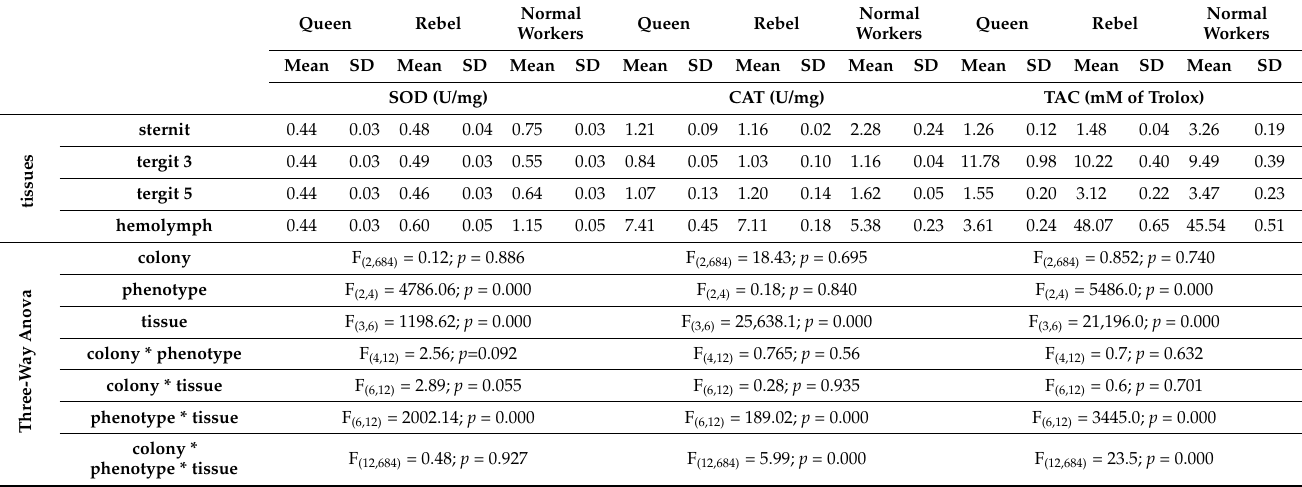
Tergit 3—the fat body from the third tergite; tergite 5—the fat body from the fifth tergite; *—interaction. The activities of SOD and CAT were the highest among the normal workers in compar- ison to the queens and rebels (Table 2). SOD activities in the queens were at the same levels in all tissue types/localisations. SOD and CAT had the highest activities in the hemolymph as compared to the other tissue types/localisations (the exception was SOD in the queens). Table 2. Activities of the antioxidant system in the fat body and hemolymph of the A. mellifera queens, rebels, and normal (sterile non-rebel)